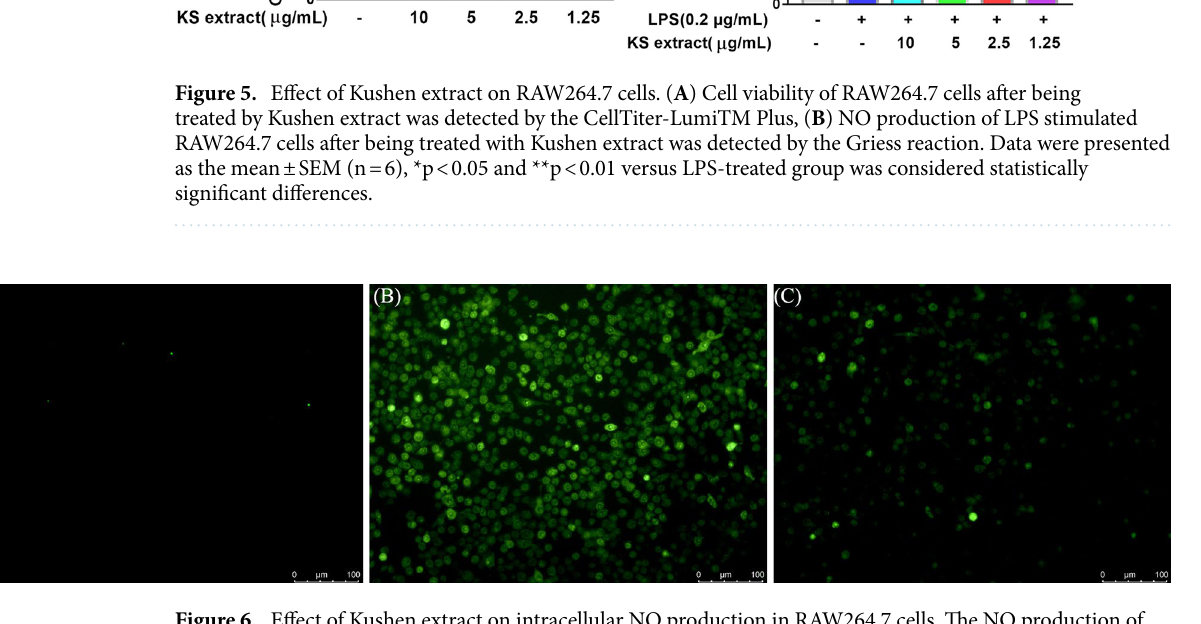
Figure 6. Effect of Kushen extract on intracellular NO production in RAW264.7 cells. The NO production of ( A ) Control group, ( B ) LPS-stimulated group, and ( C ) LPS-stimulated treated with Kushen extract group were determined by DAF-FM